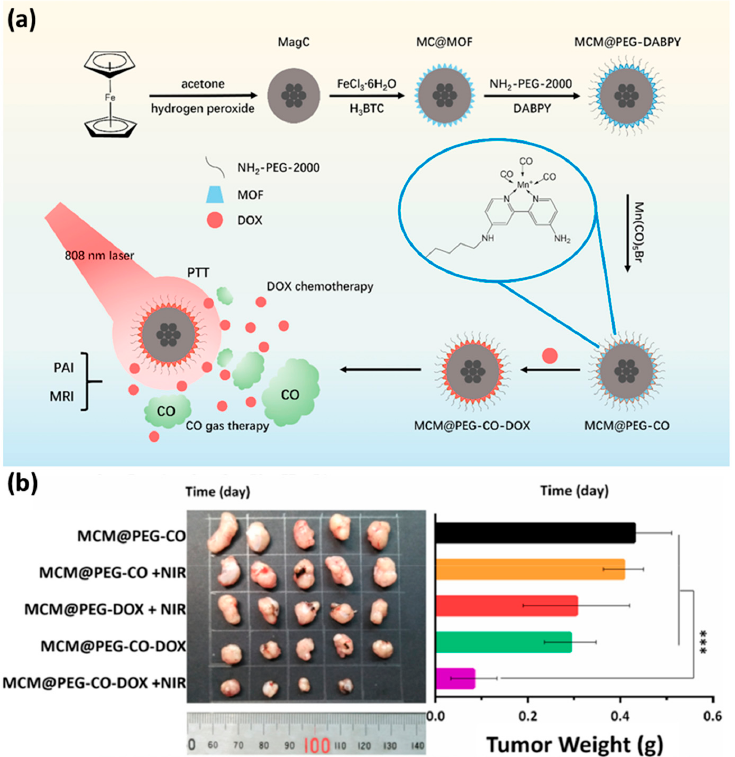
Figure 7. ( a ) Schematic illustration of the MCM@PEG–CO–DOX for NIR light–stimulated CO–DOX combination therapy of tumor. ( b ) Image and weight of mouse tumors after different treatments. Statistical analysis was based on Student’s t test: *** p < 0.001. Reproduced with permission from Ref. [120]. Copyright 2019, Elsevier.